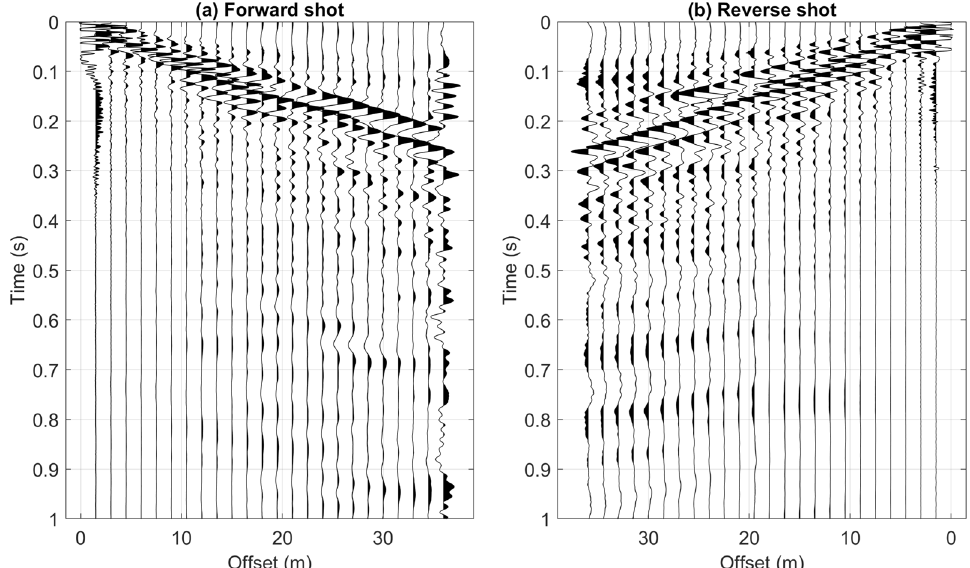
Fig. 3 Active source data. a Stack of 8 sledgehammer shots in the forward direction (Table 2). b Stack of 9 sledgehammer shots in the reverse direction. Trace normalization is applied to enhance the surface wave arrivals at large offsets for visualization only